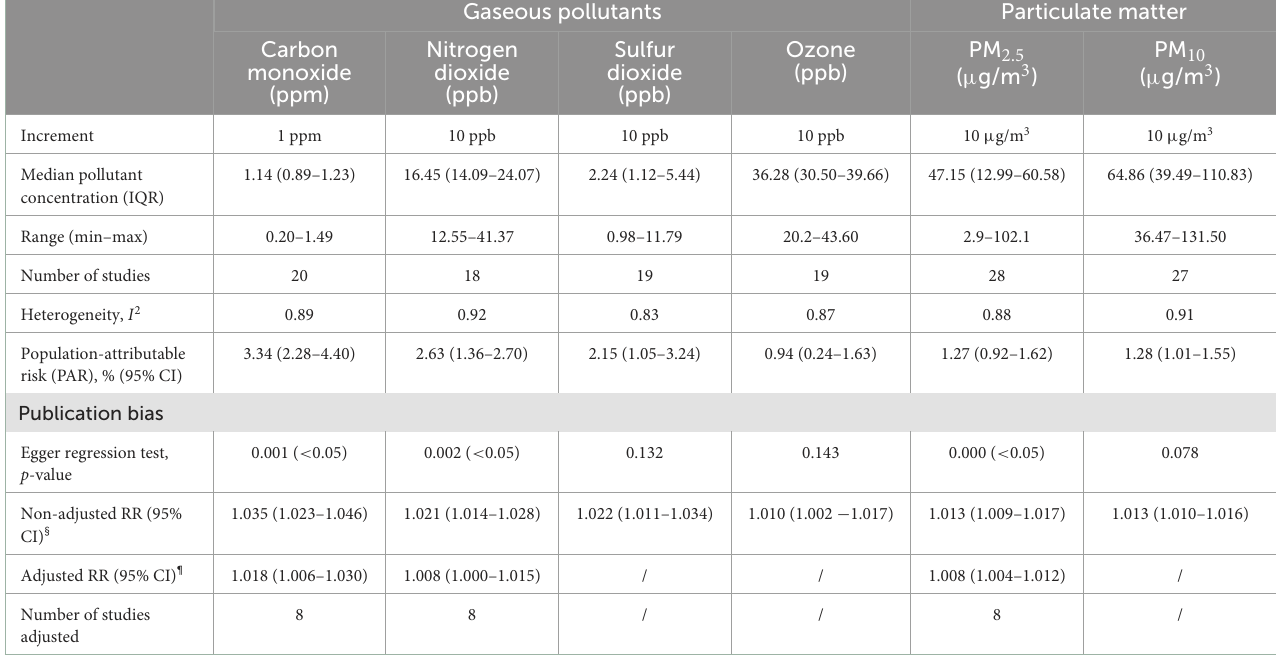
TABLE 2 Heterogeneity, population-attributable risk, and assessment for publication bias stratified by gaseous and particulate air